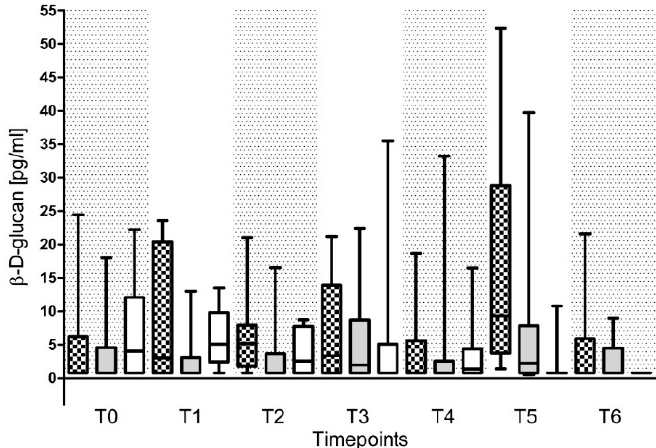
Figure 3. Plasma concentrations of β - D -glucan (BG) in patients with septic shock. Plasma concentrations of BG were measured in patients suffering from septic shock with a fungal infection (grey squared box), a fungal colonization (grey plane box) or without any fungal findings (white box). Plasma samples were collected at the onset of septic shock (T0), and 1 day (T1), 2 days (T2), 7 days (T3), 14 days (T4), 21 days (T5), and 28 days (T6) afterwards. Data in box plots are given as median, 25th percentile, 75th percentile with the 10th as well as 90th percentile at the end of the whiskers.